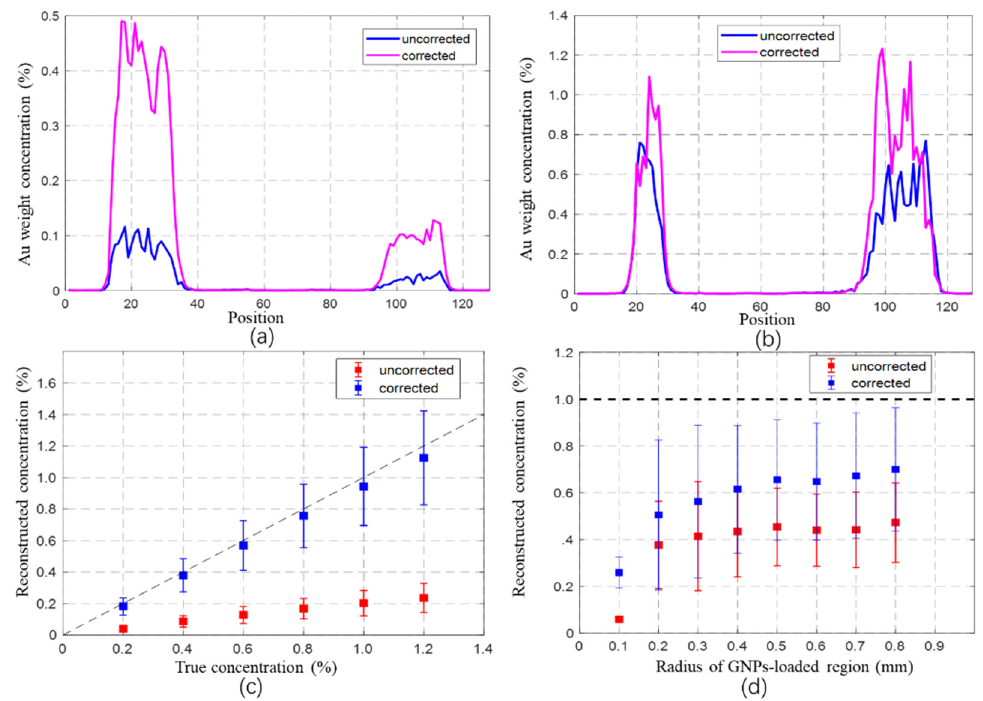
Figure 11. Profiles (red lines in Figure 10) through the phantom A and B shown in ( a , b ), respectively. Au weight concentration reconstructed by MLEM without correction and with correction shown in ( c , d ).